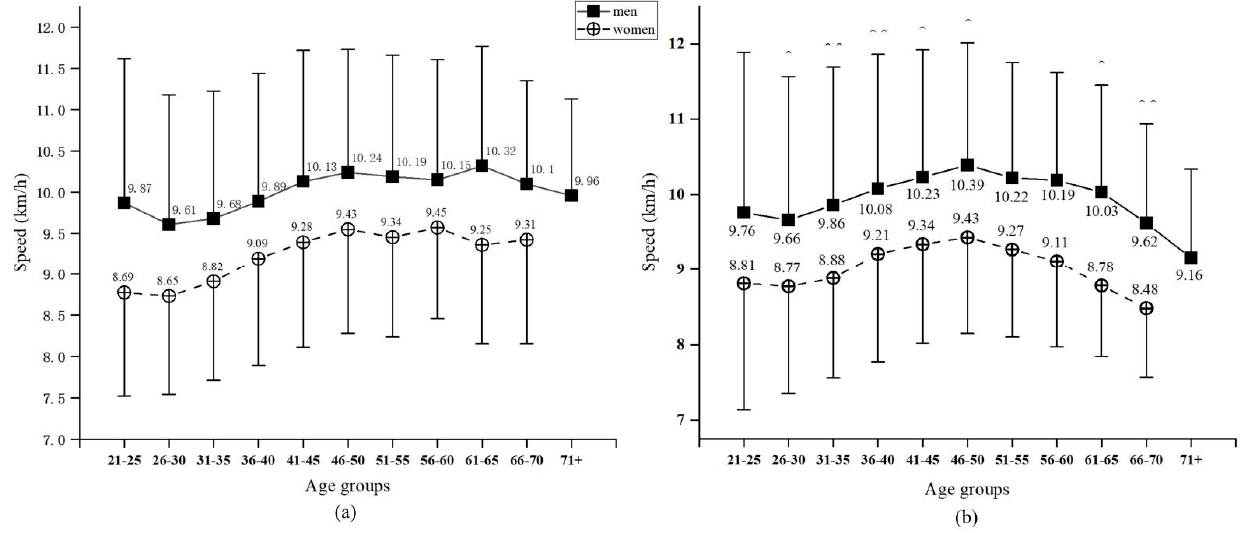
Figure 2. Race speed by age group and gender in the half-marathon event ( a ) and in the full-marathon event ( b ). Error bars represent standard deviations. ## p < 0.01; # p < 0.05. ^^ p < 0.01; ^ p < 0.05.